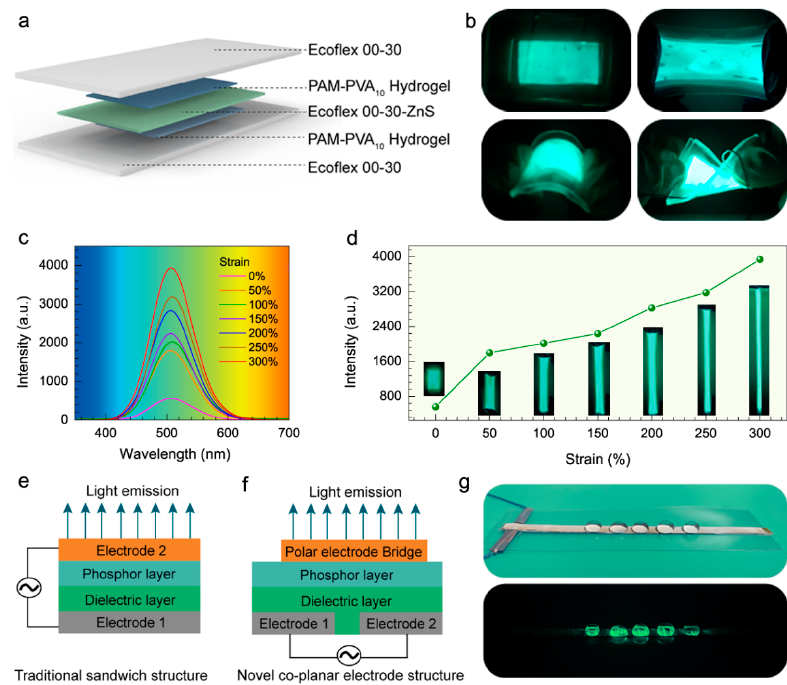
Figure 4. Structure and luminescent properties of bio-inspired electroluminescent skin. ( a ) Structural diagram of the stretchable electroluminescent skin device. ( b ) Photographs of the luminescence performance under bending and twisting deformations of the device. ( c ) Spectra under different stretching rates. ( d ) Corresponding spectrum intensity and optical photographs at different stretch rates. ( e ) Conventional sandwich structure. ( f ) Novel coplanar electrode structure. ( g ) Photograph of luminescence in water.